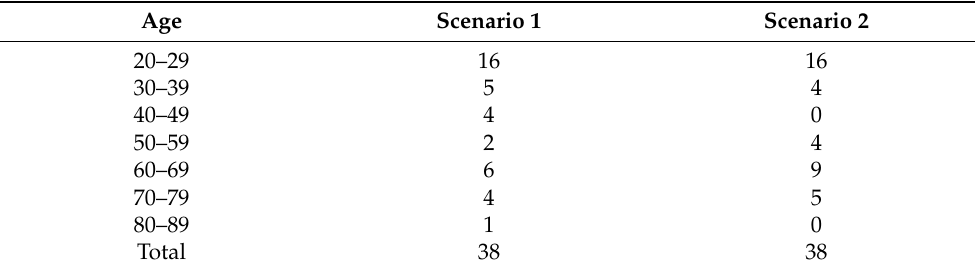
Table 2. Sample size in scenario 1 and